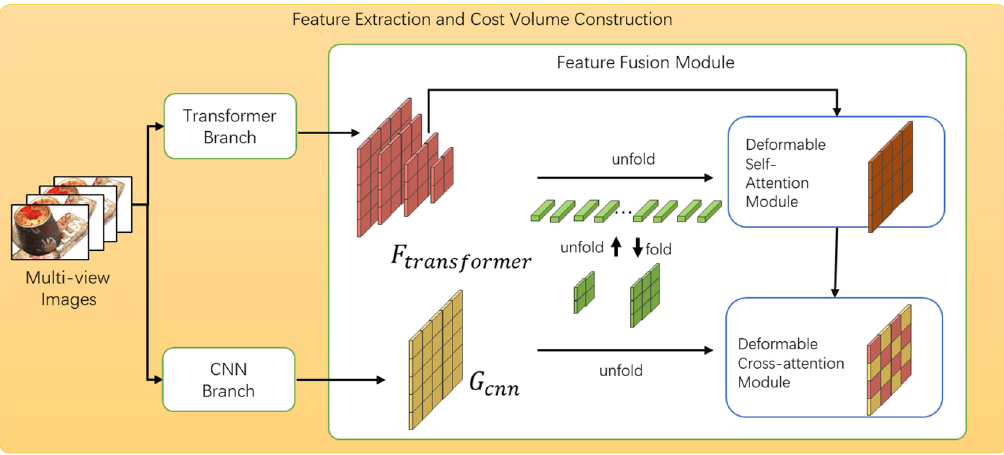
Figure 4. Overview of feature fusion part.